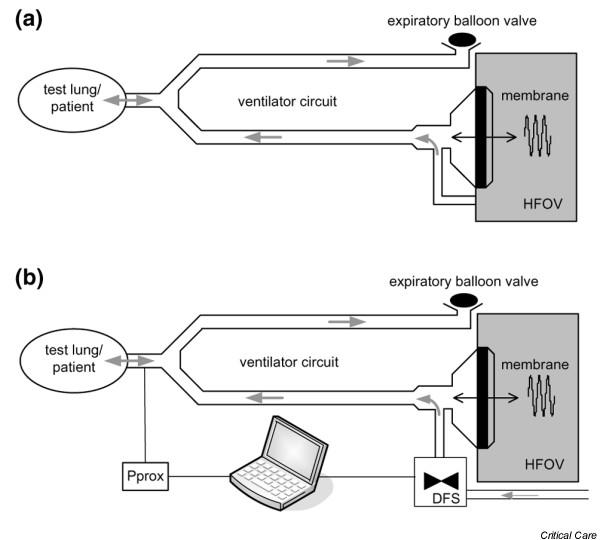
Scheme of the 3100B high-frequency oscillatory ventilator (HFOV) and the demand-flow system (DFS) connection. (a) The basic principle of the 3100B high-frequency oscillator. (b) Schematic drawing of the connection of the DFS to the 3100B oscillator. Pprox, proximal airway pressure.